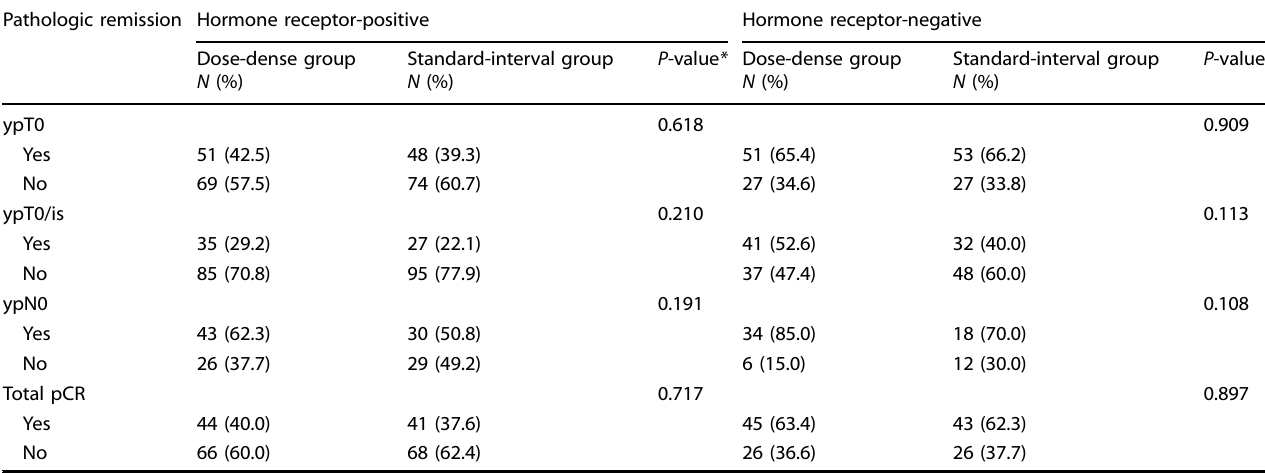
Table 3. Pathologic complete responses by chemotherapy, strati fi ed by hormone receptor status. Pathologic remission Hormone receptor-positive